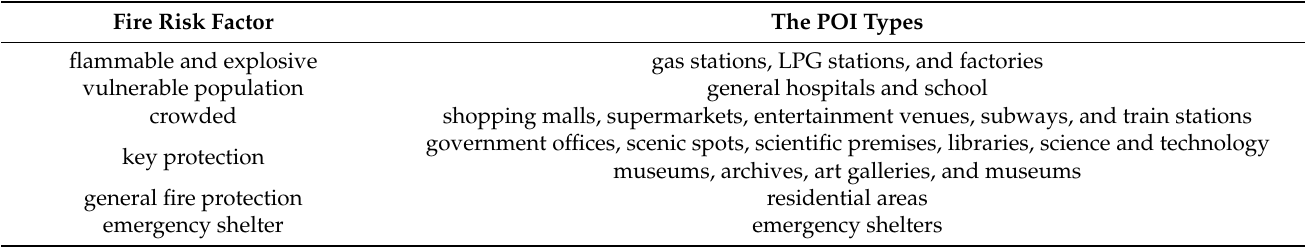
Table 1. Classification of fire risk factors.